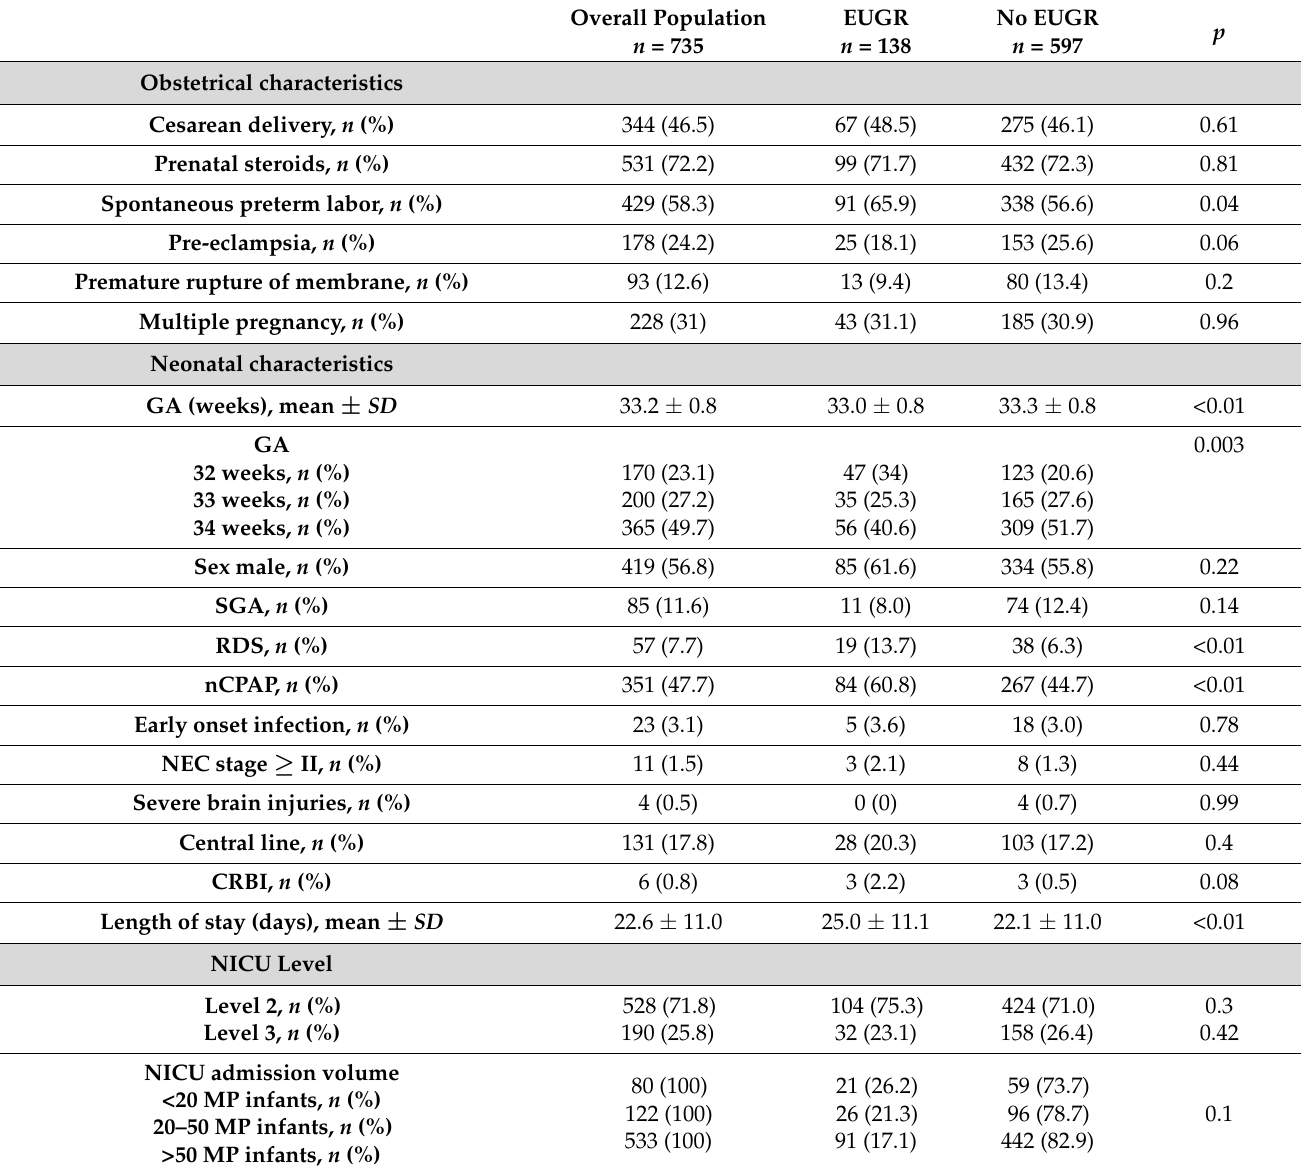
Table 1. Obstetrical and neonatal characteristics of study population by EUGR.